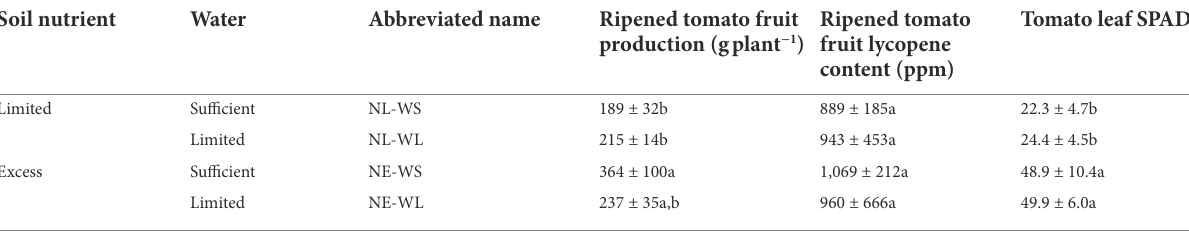
TABLE 2 Tomato fruit production per plant, lycopene contents of tomato fruits on a dry-weight basis, and leaf SPAD cultivated under varied nutrient and water conditions. Soil